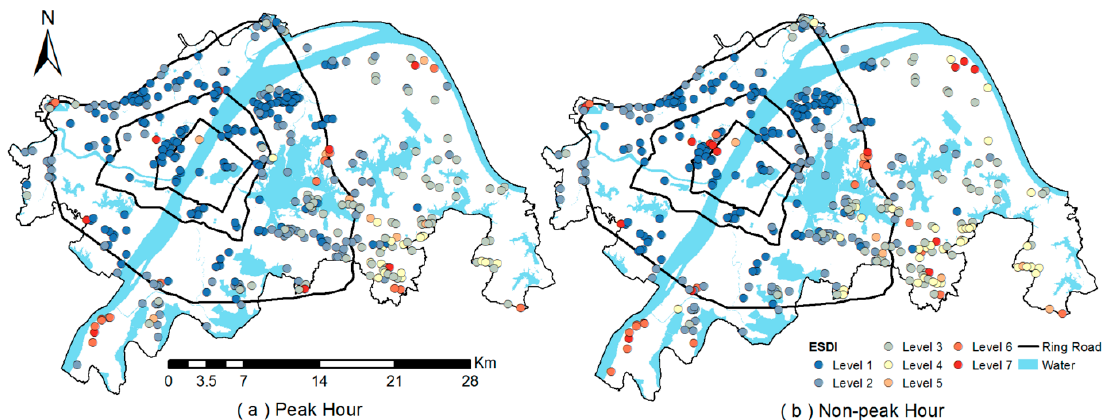
Figure 6. Evacuation supply-demand index (ESDI) distribution. ( a ) and ( b ) ESDI during peak and